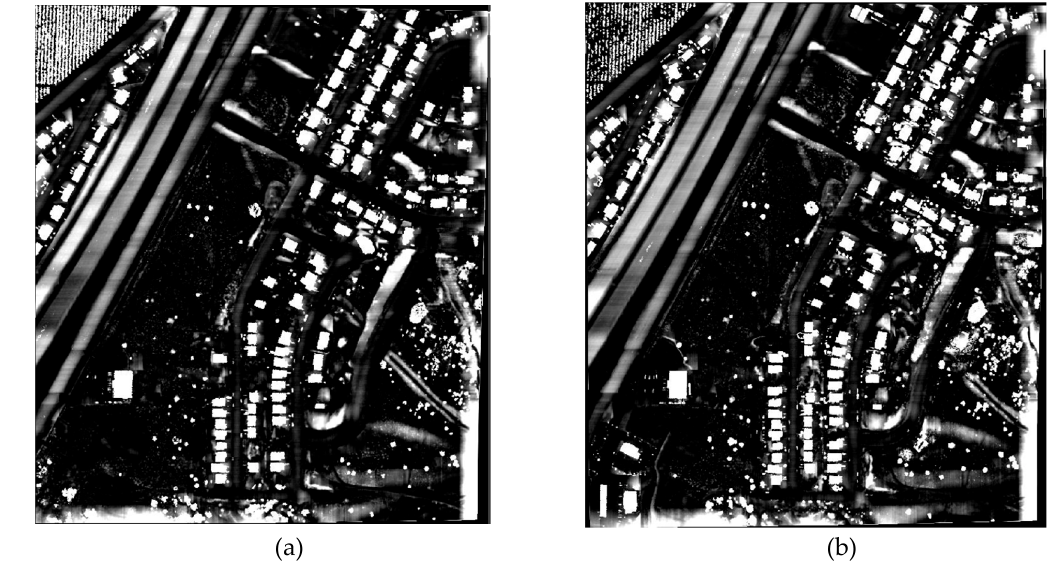
Figure 6. Output of the normalized digital surface model (nDSM). ( a ) nDSM for the first data; ( b ) nDSM for the second data.